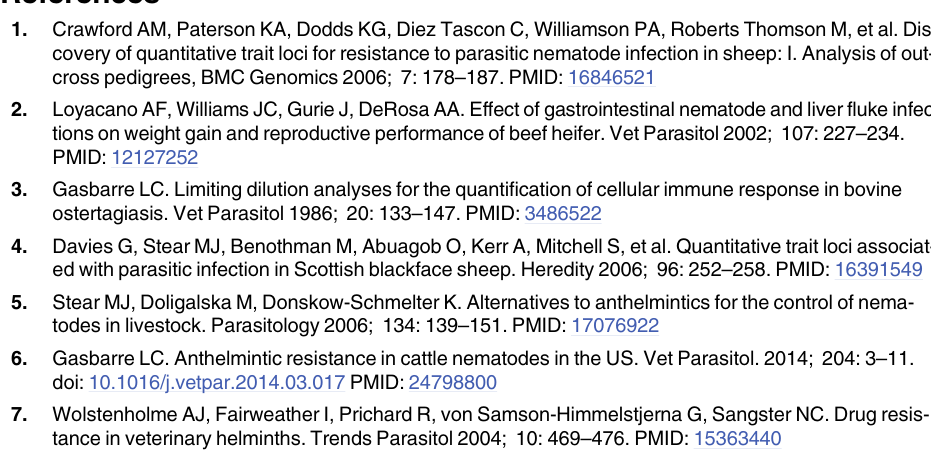
(TIF) S3 Fig. Genome-wide plot of runs of homozygosity. (TIF) S4 Fig. Signature of selection |iHS| and genomic autozygosity (ROH) at MHC locus on BTA 23. (TIF) S5 Fig. Genome plot of association test statistics between ROH and BC-MFEC. (TIF) S1 File. Contains S Fig. Legends, SNP map, Genotype, Phenotype, and Pedigree files. (ZIP) S1 Table. Summary of all significant BovineSNP50 markers associated with